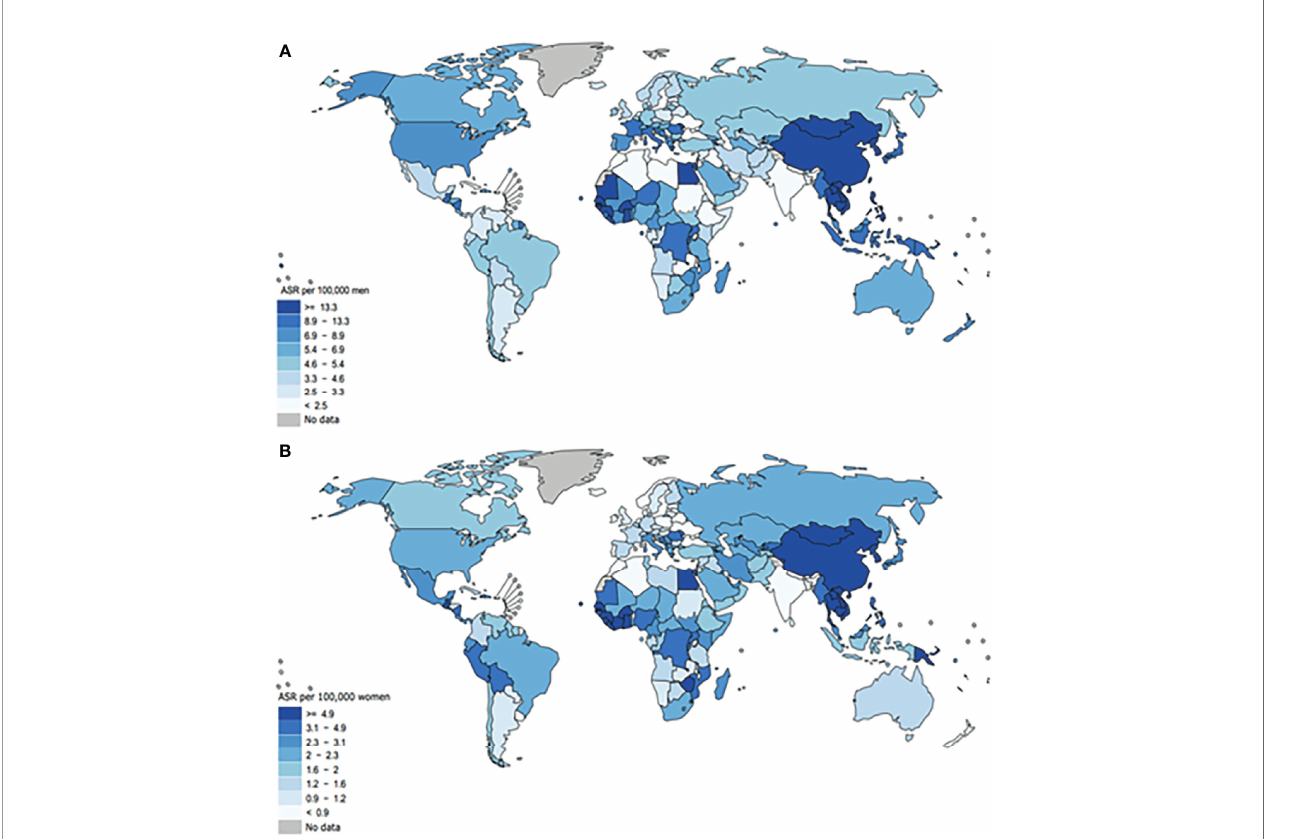
FIGURE 7 | Global age-adjusted incidence rates of liver cancer, estimated for 2020. Data source: GLOBOCAN 2020. Graph production: IARC (http://gco.iarc.fr/ today), World Health Organization (35). This article is protected by copyright. All rights reserved. the age-standardized rate (ASR) incidence of malein males is highest in China, Mongolia and some South Asian countries (>13.3/100,000) and then, followed by the United States and some African countries (8.9-13.3/100,000), Canada, Mexico and Oceania (6.9-8.9/100,000) and lowest in the Southeast Asia